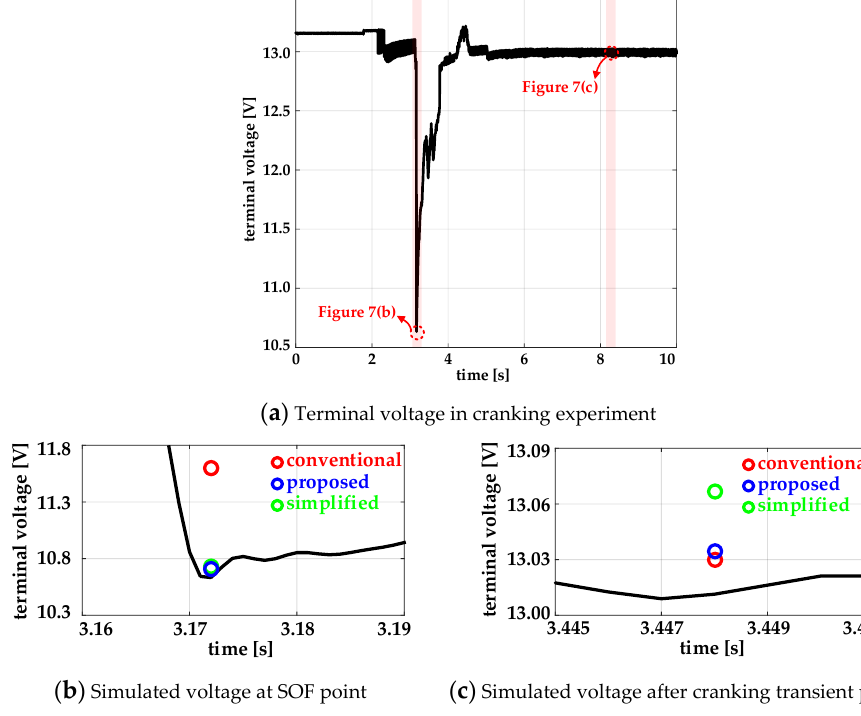
Figure 7. Verification results of proposed equivalent circuit model (ECM).